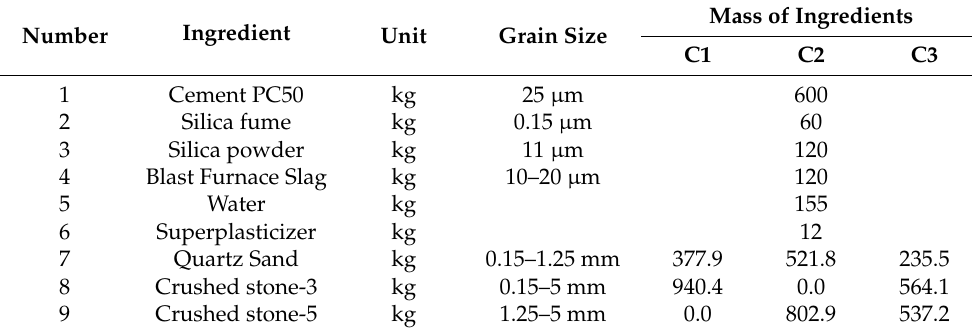
Table 7. Aggregate components for 1 m 3 of concrete.